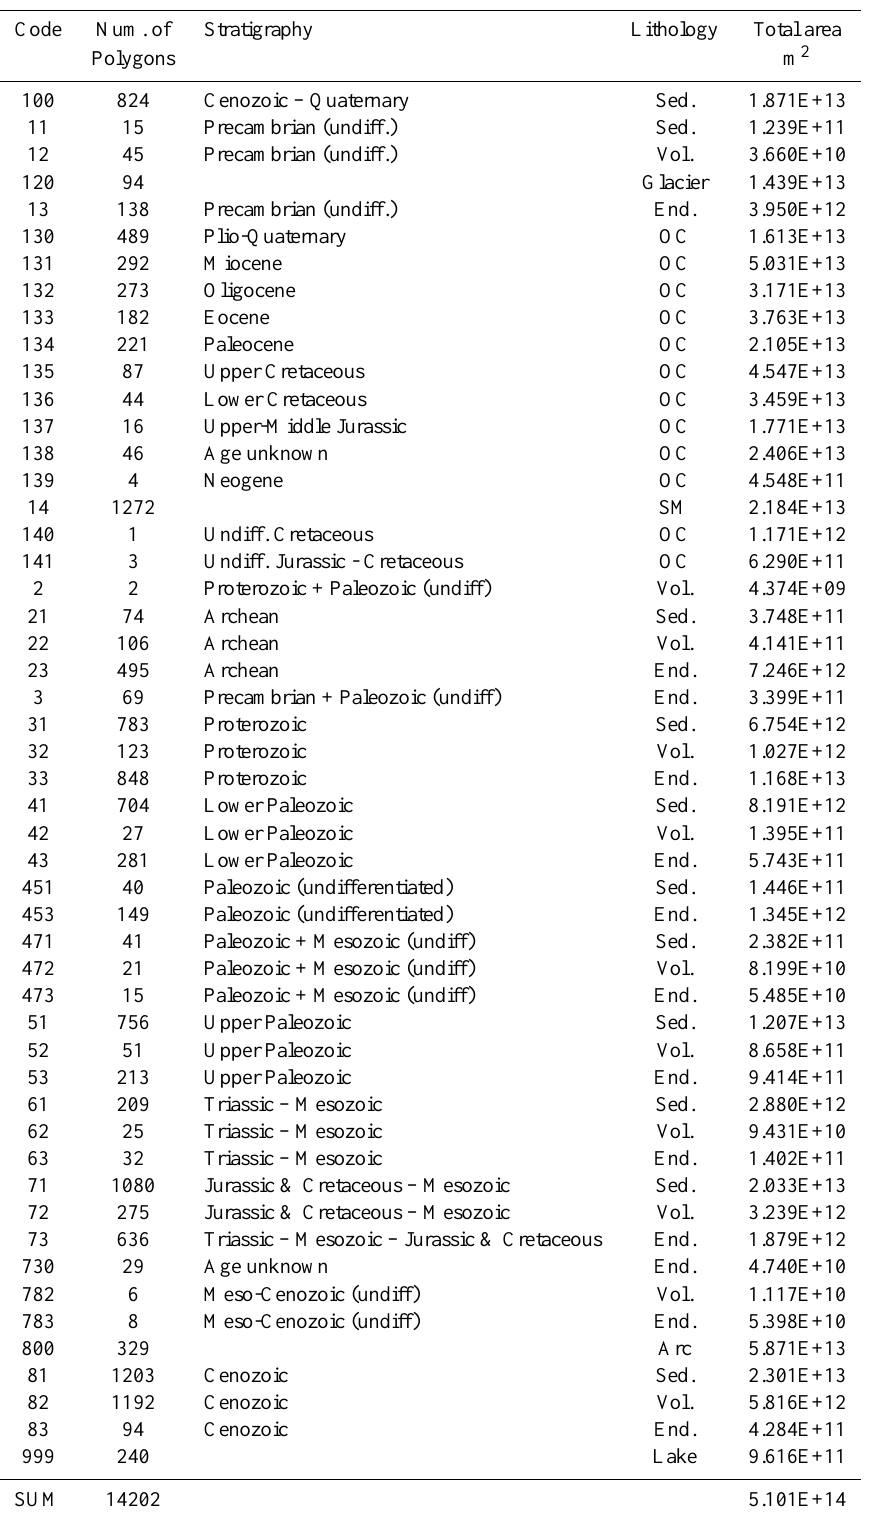
Table 1. Breakdown of the Geology in the Commission for the Geological Map of the World (2000), which we abbreviate to CCGM in the text. Sed – sedimentary rocks (or undifferentiated facies); end – endogenous rocks (plutonic and/or metamorphic); arc – continental and island arc margins; vol – extrusive volcanic rocks; SM – seamount, oceanic plateau, anomalous oceanic crust; OC – oceanic crust; undiff –